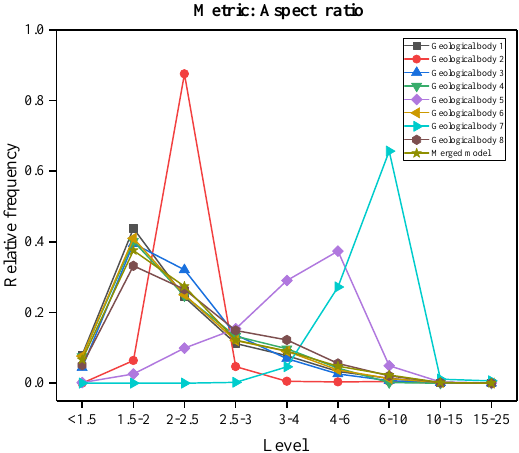
Figure 7. Statistics of the mesh quality of aspect ratio